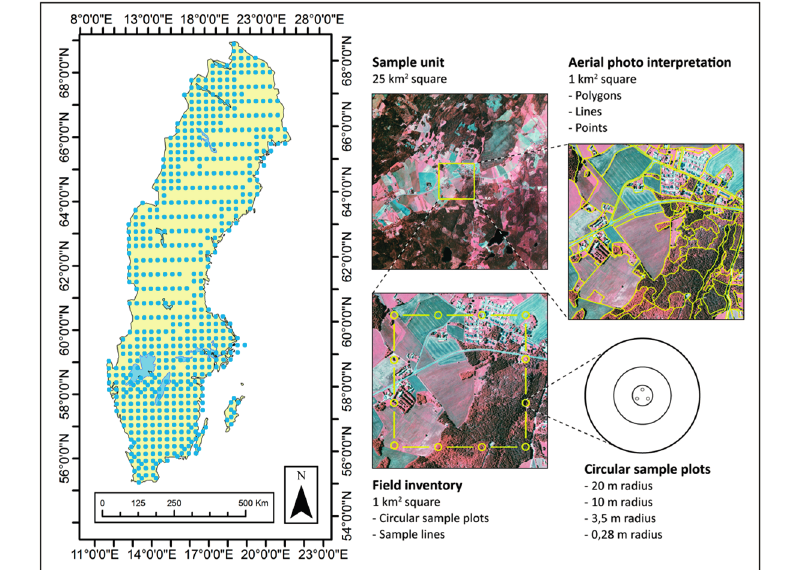
Figure 1. Illustration of the National Inventory of Landscapes in Sweden (NILS) design. The 631 clusters are systematically sampled with different densities in 10 different strata. For each cluster 12 sample plots are visited in situ and a central 1 × 1 km square is photo interpreted. An outer 5 × 5 km square is supposed to contribute with data about the surrounding landscape. No coordinates are shown here as the position of individual NILS squares are confidential to assure that the permanent sample sites are not intentionally tampered with in any